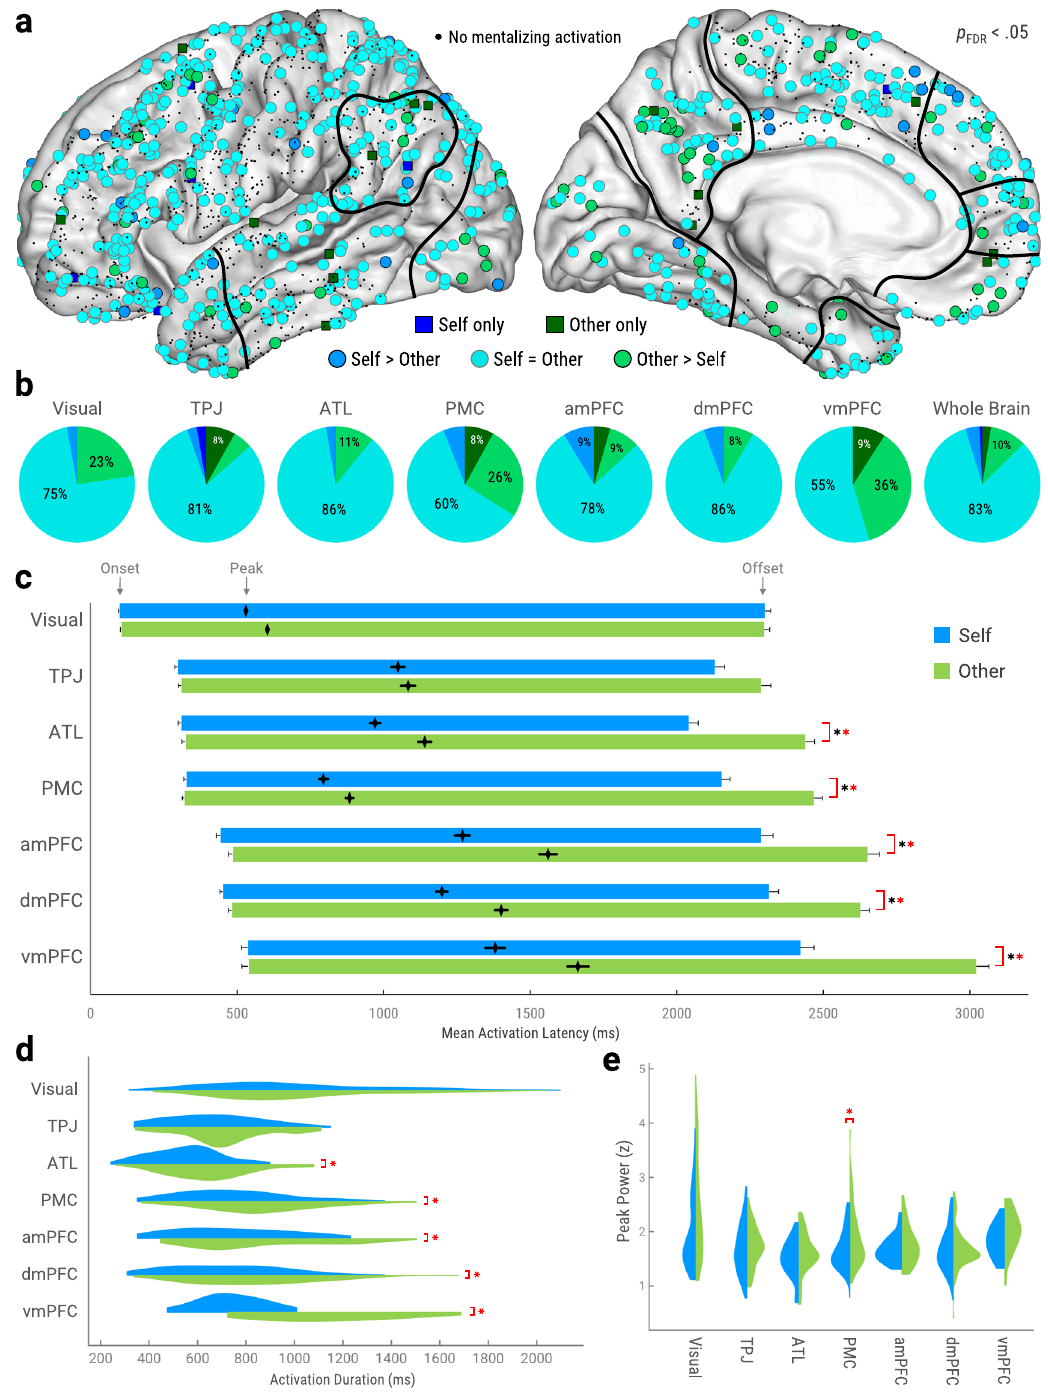
Fig. 5 A common neurocognitive sequence for self- and other-mentalizing. a Functional anatomy of self- and other-mentalizing. Circles represent sites identi fi ed as coactive for both mentalizing types versus baseline ( p FDR < 0.05, corrected across timepoints and sites), colored by self/other differences in peak power ( p FDR < 0.05, corrected across sites; see Fig. 2). Squares represent sites identi fi ed as active for only one mentalizing type with signi fi cantly higher peak power for that mentalizing type. Black dots represent sites with nonsigni fi cant mentalizing activations. All sites plotted on left hemisphere with approximate ROI outlines (full views in Supplementary Fig. 9). b Proportions of mentalizing-active ROI sites exhibiting the selectivity pro fi les in a . ‘ Whole Brain ’ refers to all mentalizing-active sites in cortex. c Mean activation latencies by mentalizing type and ROI. Left and right fl oating bar edges depict onsets and offsets, respectively, while diamonds depict peaks (see Fig. 1e). Error bars depict standard error of the mean. *Signi fi cant self/other differences for peaks (black) and offsets (red); p < 0.05, uncorrected, controlled for RT Behav and stimulus visual dissimilarity, two-tailed. Activation duration ( d ) and magnitude ( e ; peak power) by mentalizing type and ROI. *Red asterisks indicate signi fi cant self/other differences ( p < 0.05, uncorrected, controlled for RT Behav and stimulus visual dissimilarity, two-tailed). See Table 1 for exact statistics and n for c – e . Abbreviations: ROI = region-of-i n terest, Visual = visual cortex, ATL = anterior temporal lobe, TPJ = temporoparietal junction, PMC = posteromedial cortex, amPFC = anteromedial prefrontal cortex, dmPFC = dorsomedial prefrontal cortex, vmPFC = ventromedial prefrontal cortex, z = z-score. Source data are provided as a Source Data fi le. NATURE COMMUNICATIONS| (2022) 13:1919 |https://doi.org/10.1038/s41467-022-29510-2|www.nature.com/naturecommunications